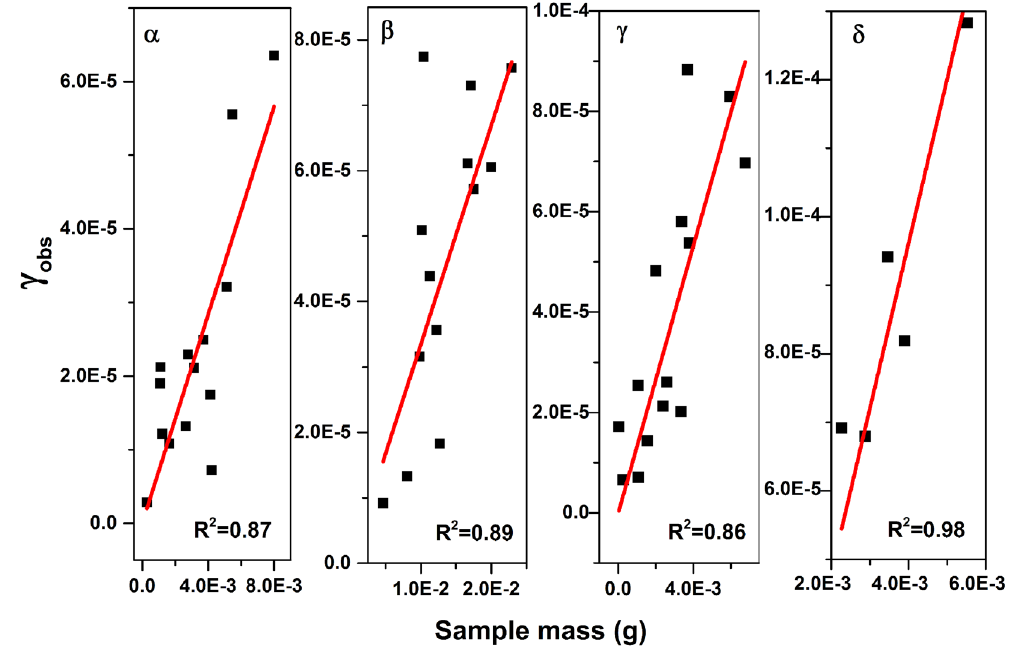
Figure 6. Linear mass dependence for γ obs on manganese oxides under dry conditions.